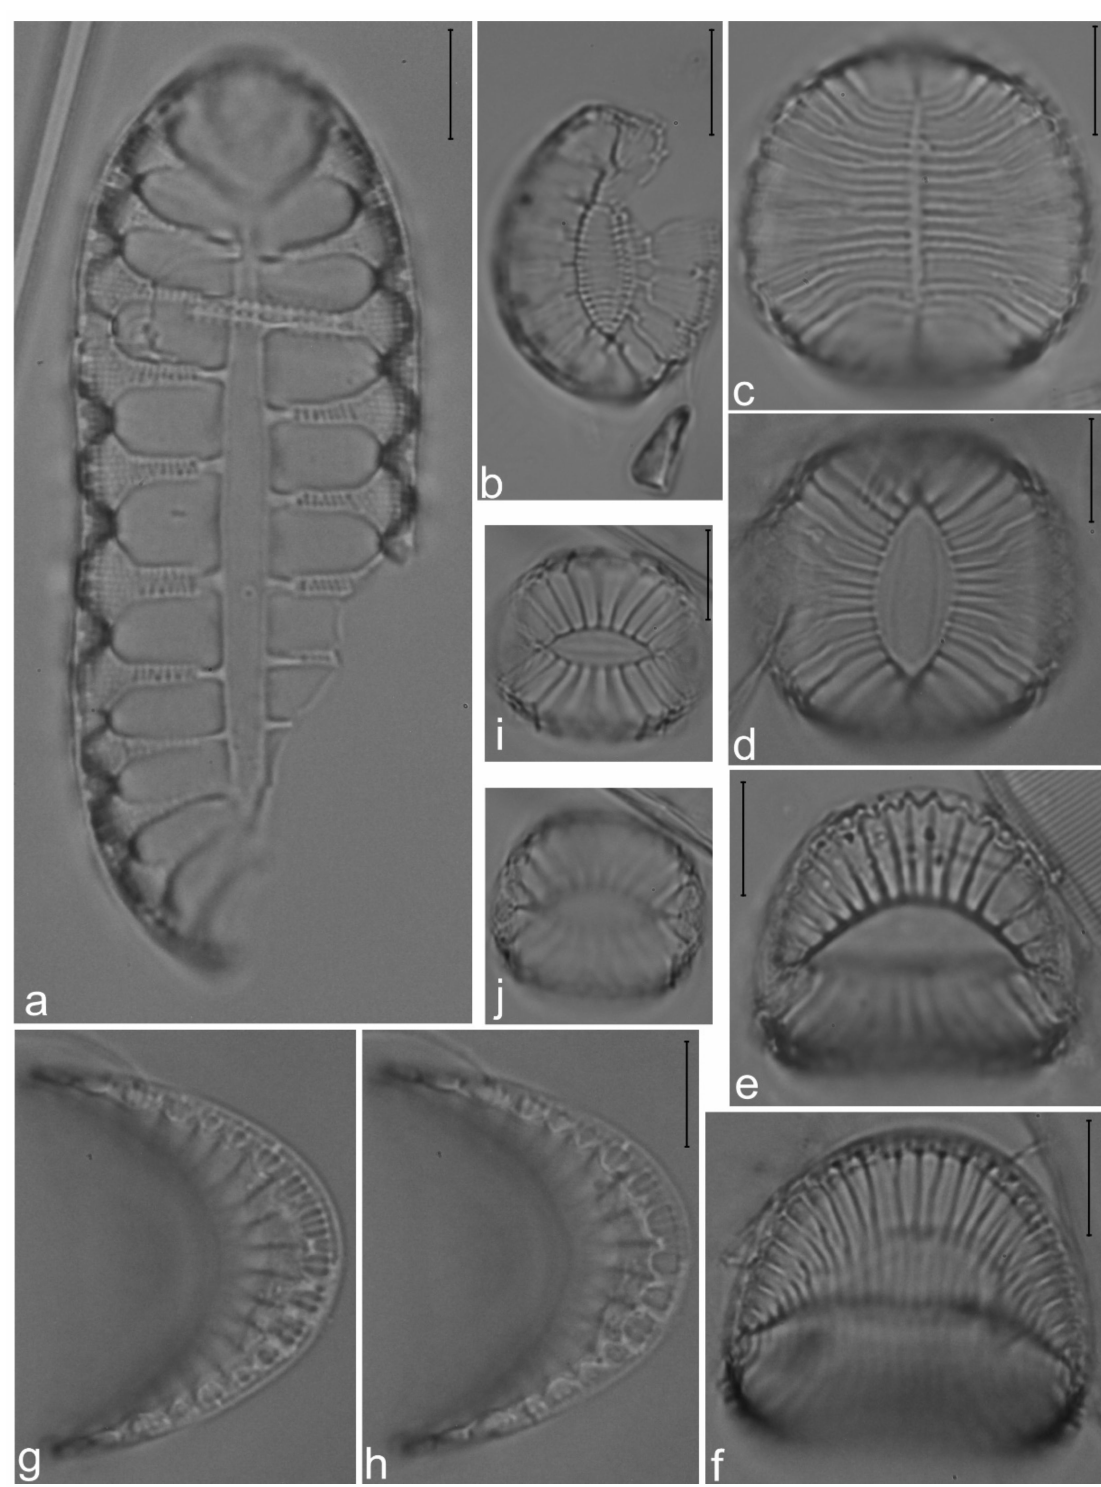
Figure 30. ( a , b ) Campylodiscus neofastuosus ; ( c ) Coronia decora ; ( d , e , i , j ) Campylodiscus subangularis in different focal planes; ( f – h ) C . cordatus . Scale bar = 10 µ